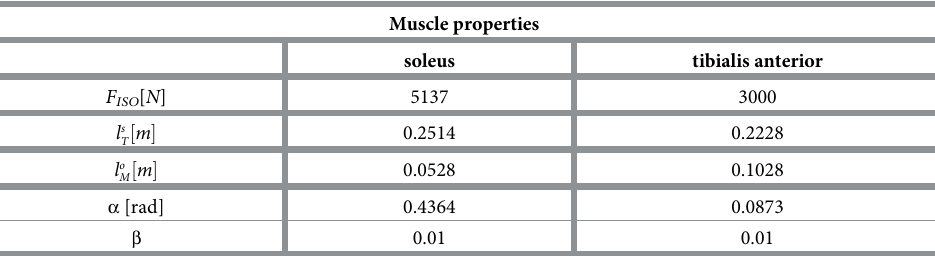
Table 1. Muscle properties of model for perturbed standing